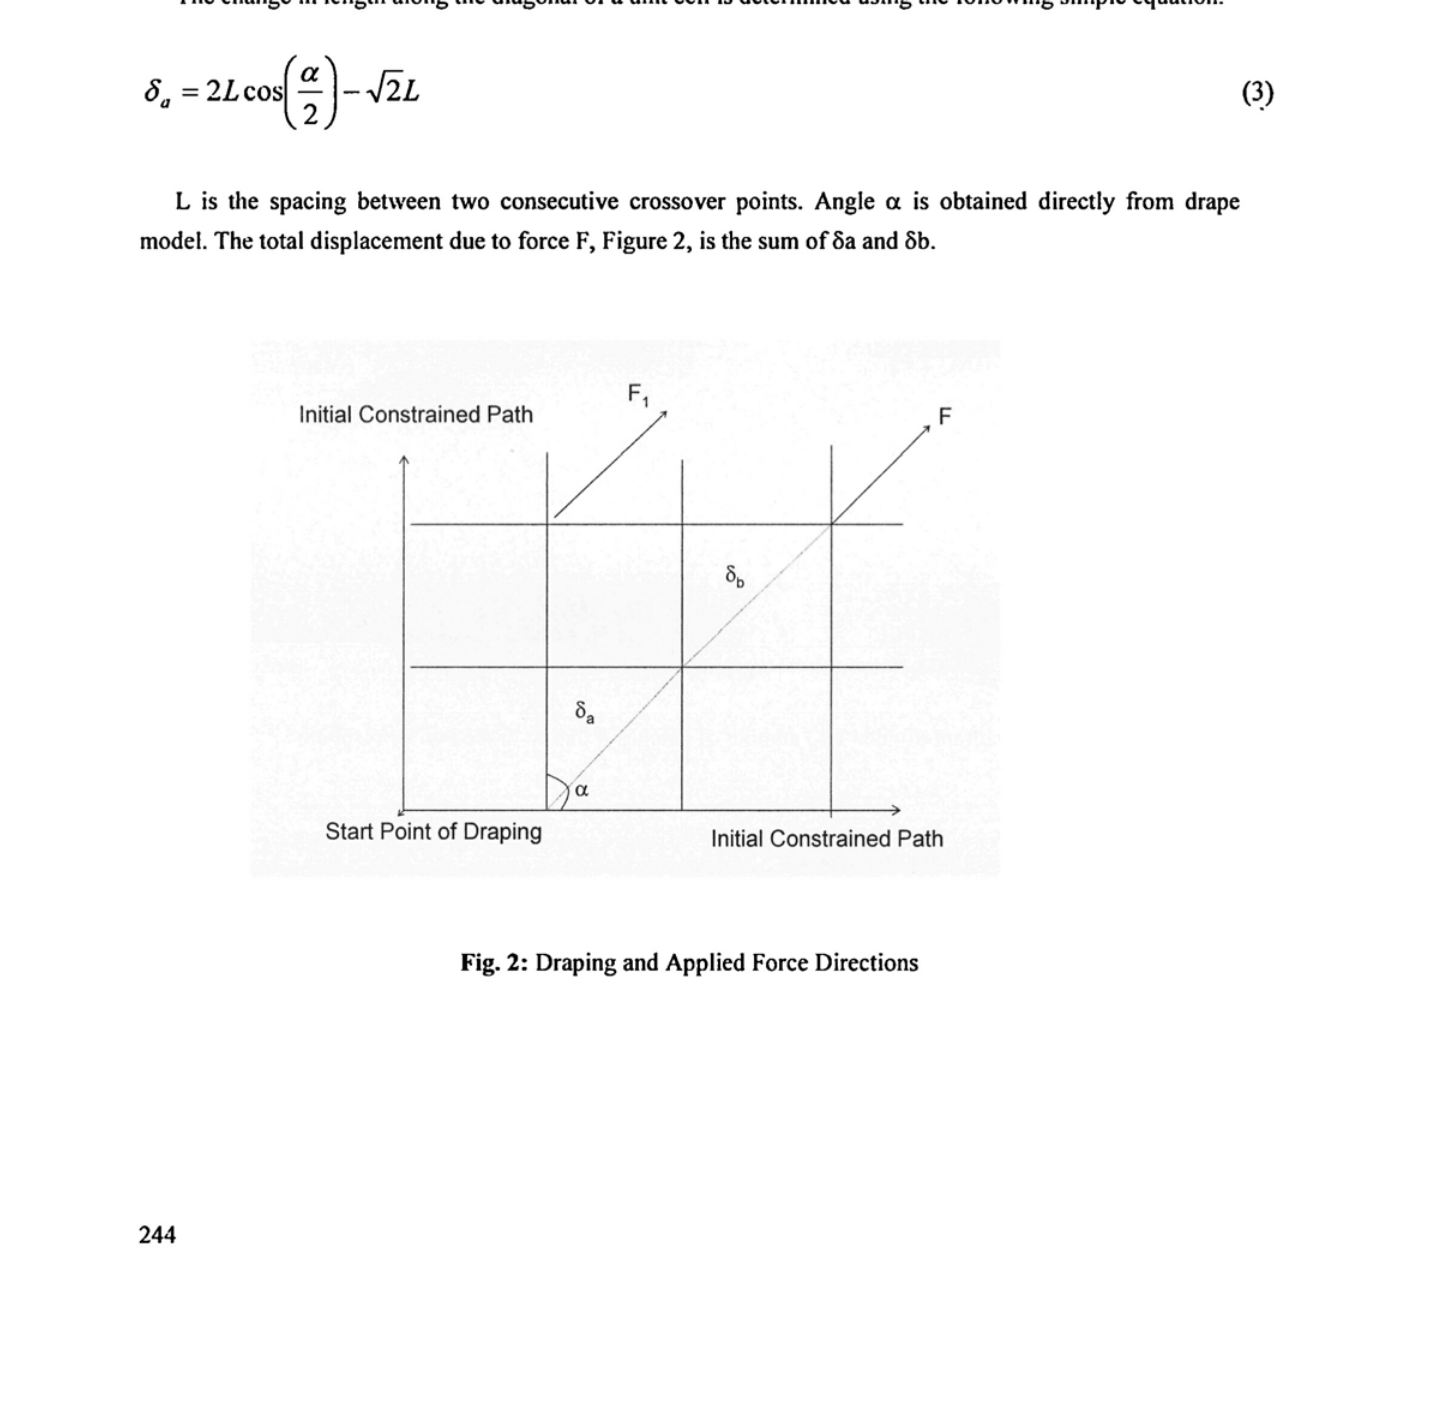
Fig. 2: Draping and Applied Force